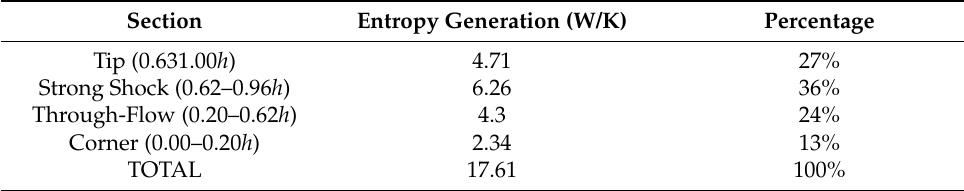
Table 2. Comparison of entropy generation for the sections.